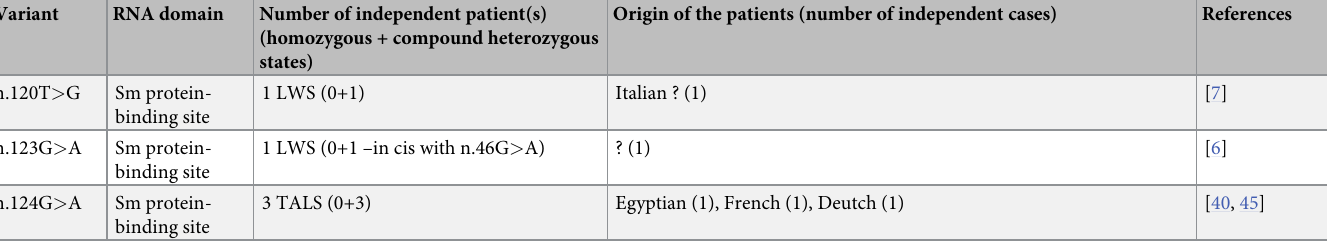
PLOS ONE | https://doi.org/10.1371/journal.pone.0235655 July 6,